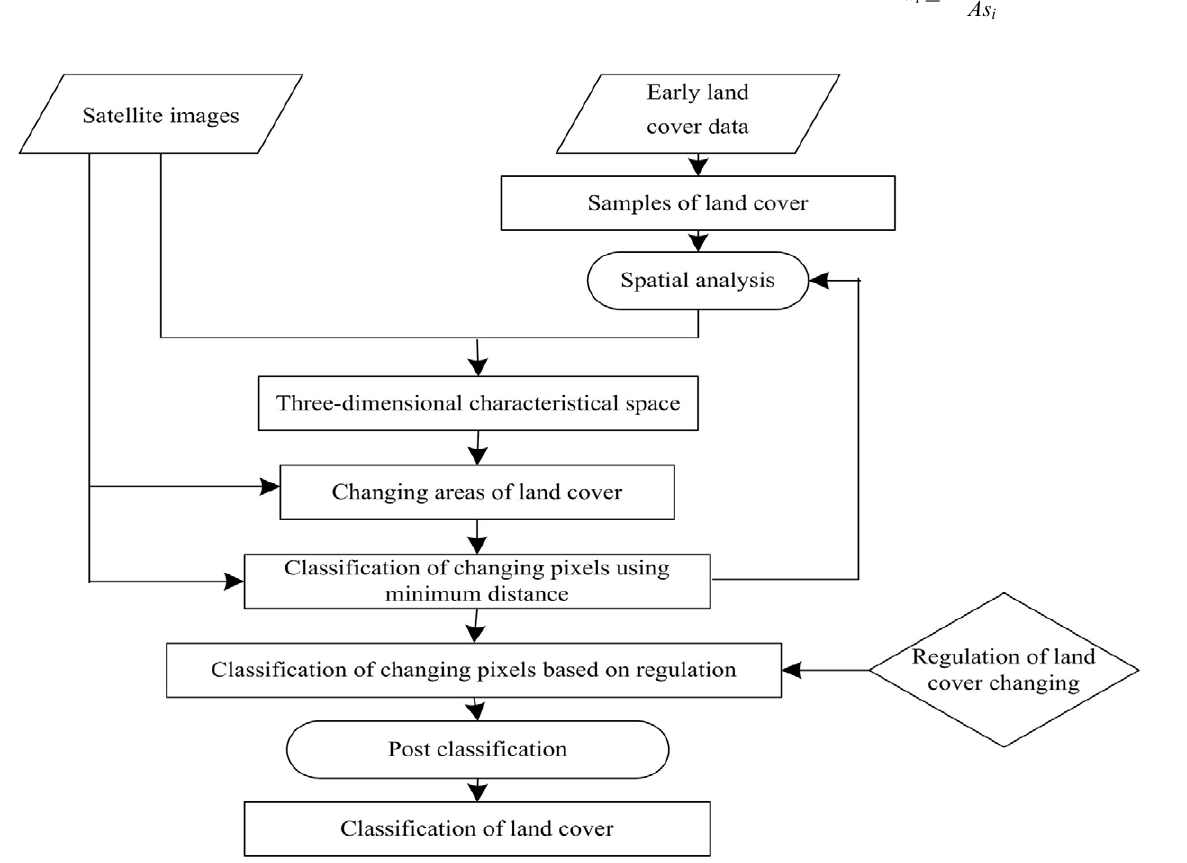
Figure 1. Flowchart of proposed land cover classification method.